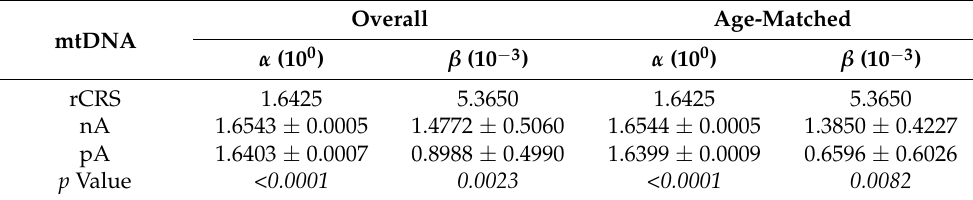
Table 4. Fractal parameters of mtDNA in age-matched subjects.